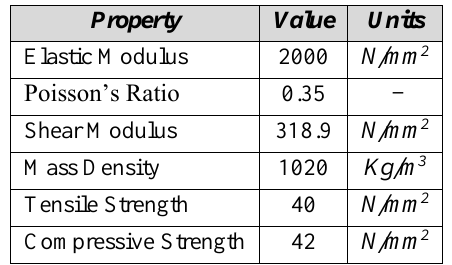
Table 2. Mechanical properties of the Acrylonitrile Butadiene Styrene (ABS).